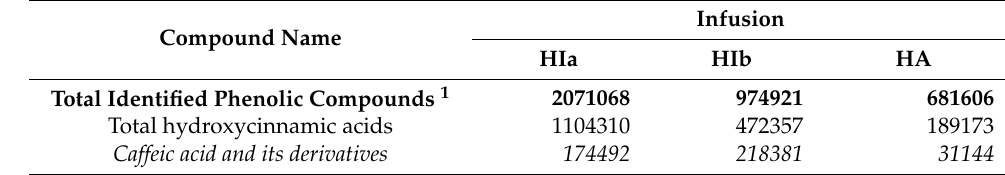
Table 1. HPLC–MS analysis of the infusions. Semiquantitative analysis was preformed to compare the abundances of the main components in HIa, Hib, and HA. The relative abundances are presented for each infusion. Calculations were performed based on abundance summation of individual compounds belonging to each subclass and class. Names of subclasses are written in